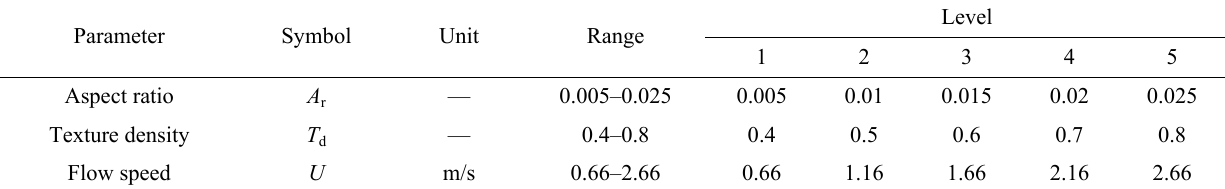
Table 2 Variable parameters for the analysis.